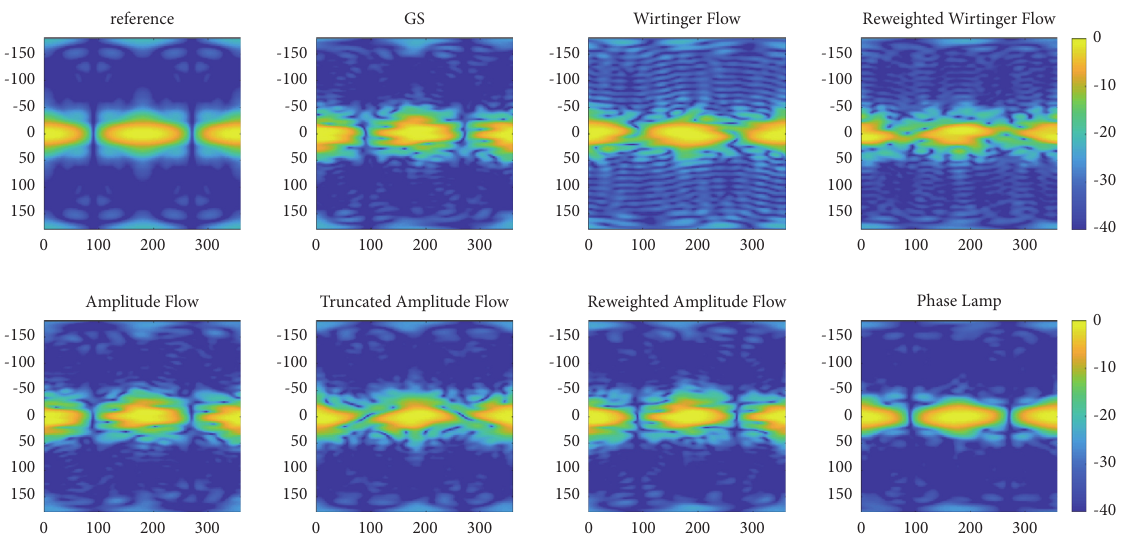
Figure 19: The reconstructed E